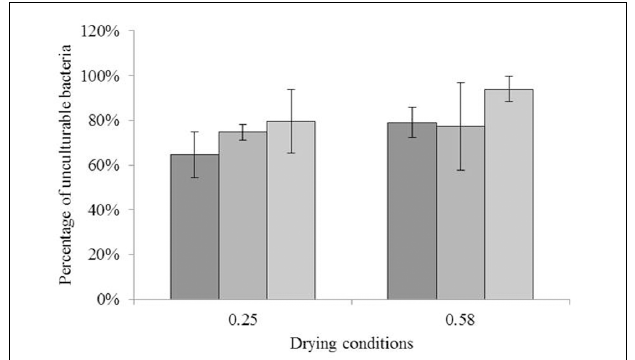
FIGURE 1 | Impact of drying on culturability. Impact of drying (16 h) on culturability of each species; the bars from darker to lighter show the percentages of unculturable Cronobacter sakazakii , Salmonella Typhimurium, and Salmonella Senftenberg cells as a function of the water activity level of drying. The equivalent logarithmic inactivation is indicated above each bar. Error bars represent the standard deviation obtained using independent triplicates. The corresponding logarithmic inactivation numbers are presented in Supplementary Table S1 .